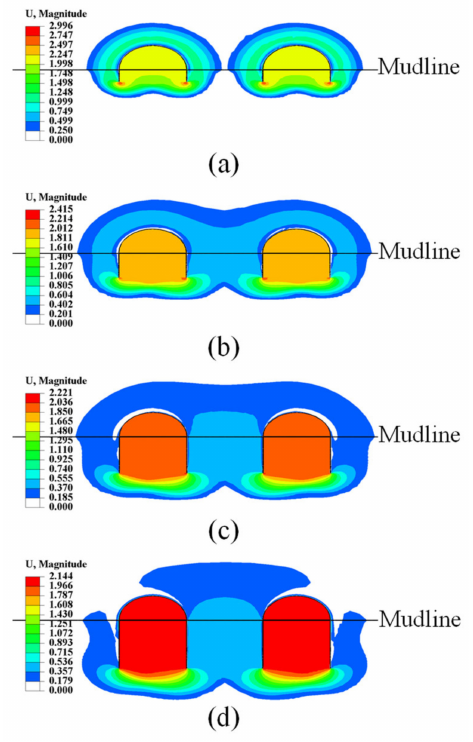
Figure 8. The magnitude of displacement contours of tetrapod bucket foundations and soils under ultimate vertical loading at s/D = 1.5 and κ = 10 when ( a ) d/D = 0.25, ( b ) d/D = 0.5, ( c ) d/D = 0.75 and ( d ) d/D =